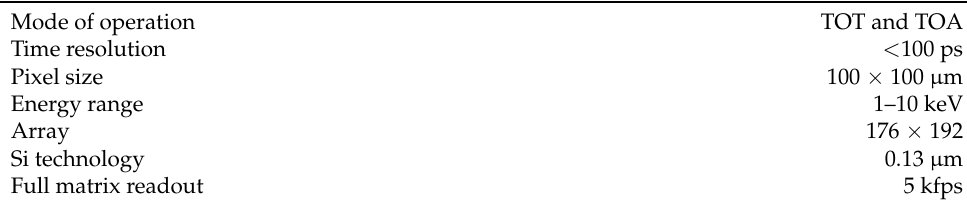
Table 2. TIXEL key performance parameters.